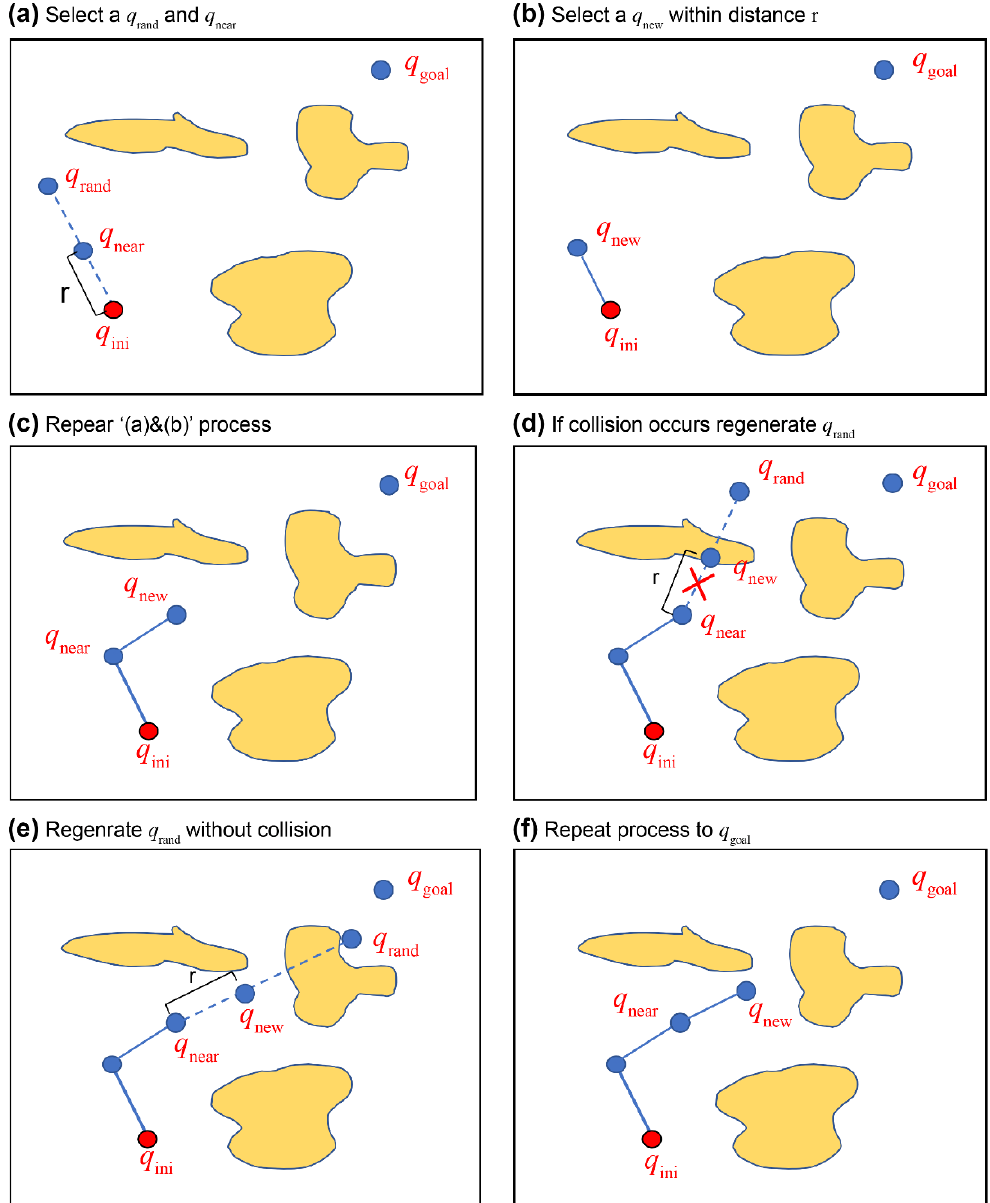
Figure 4. The rapidly-exploring random tree (RRT) algorithm’s search process: ( a ) Select a q rand and q near , ( b ) select a q near within distance r , ( c ) repeat ‘(a) and (b)’ process, (d) if collision occurs regenerate q rand , ( e ) regenerate q rand without collision, and ( f ) repeat process to q goal